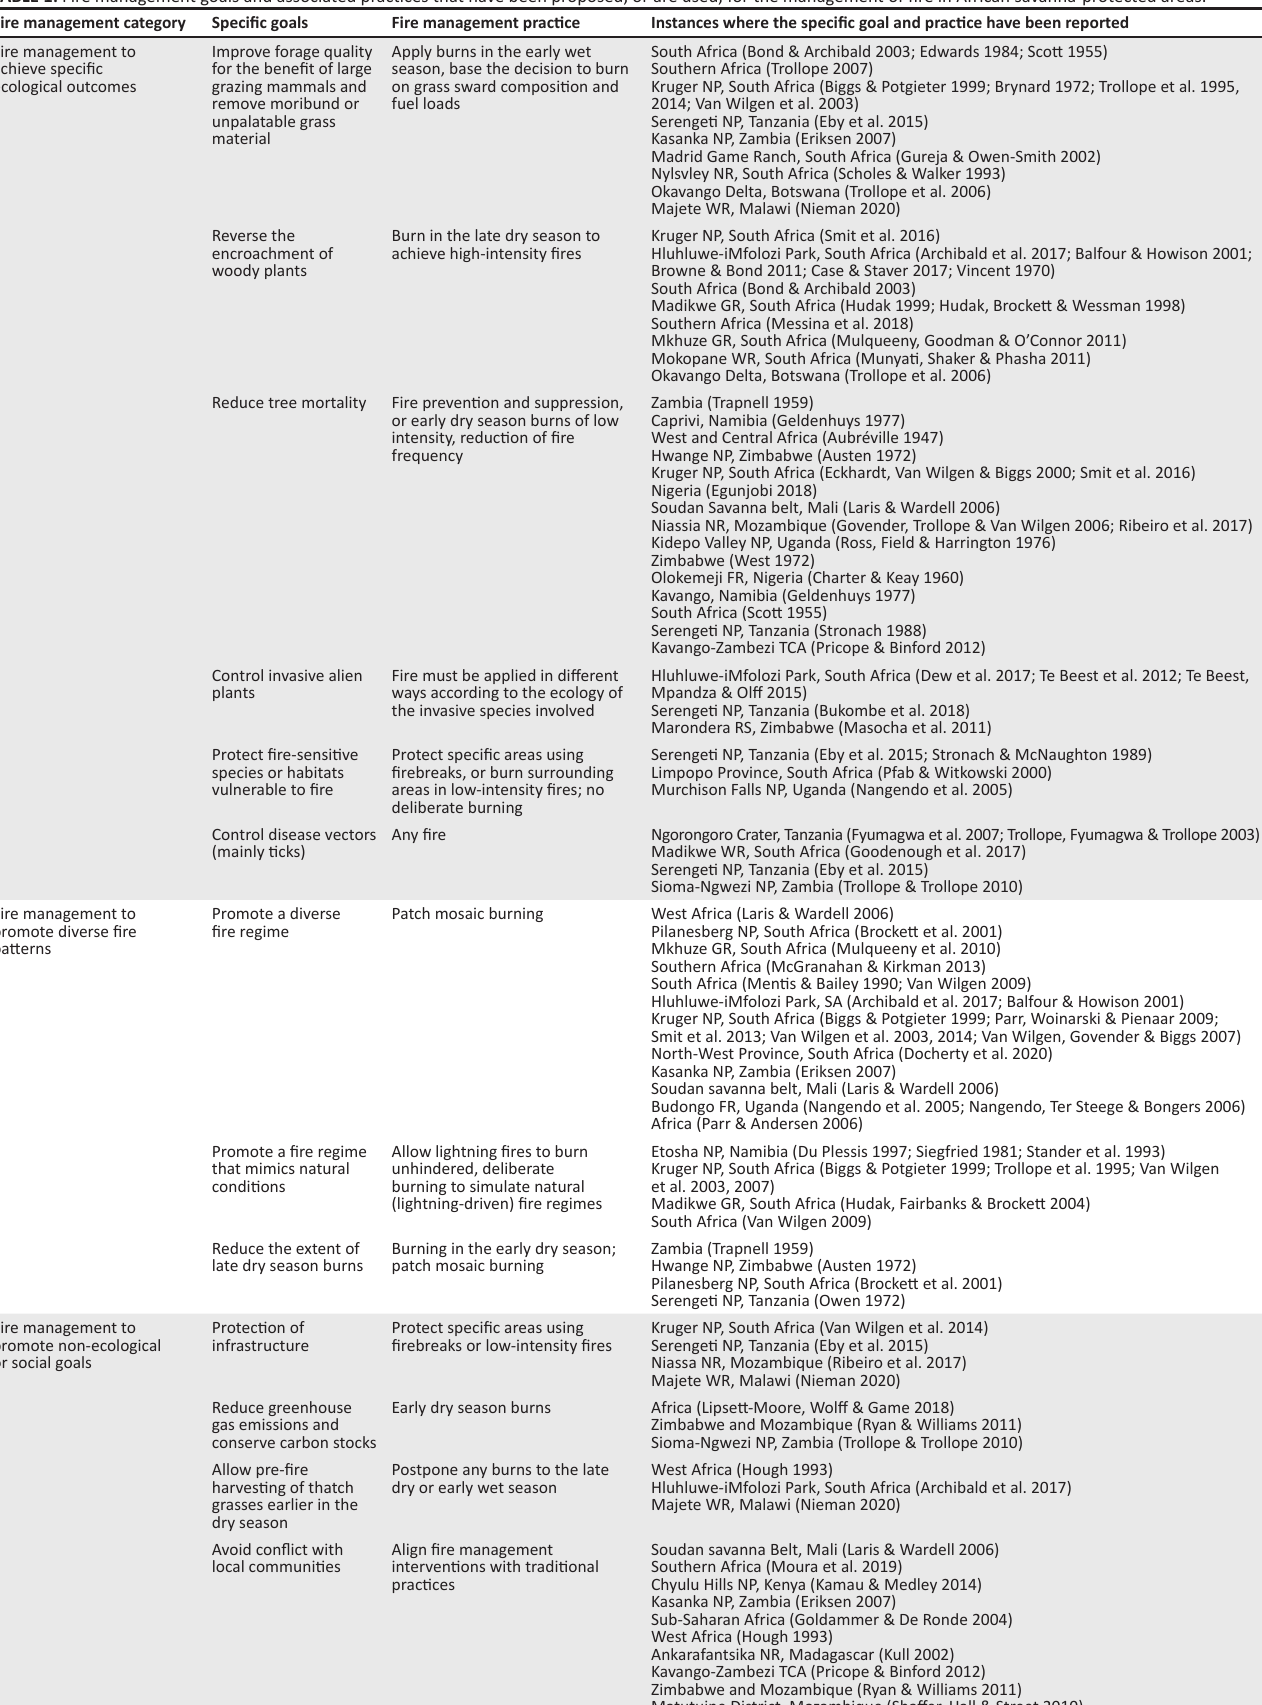
TABLE 1: Fire management goals and associated practices that have been proposed, or are used, for the management of fire in African savanna-protected areas. Fire management